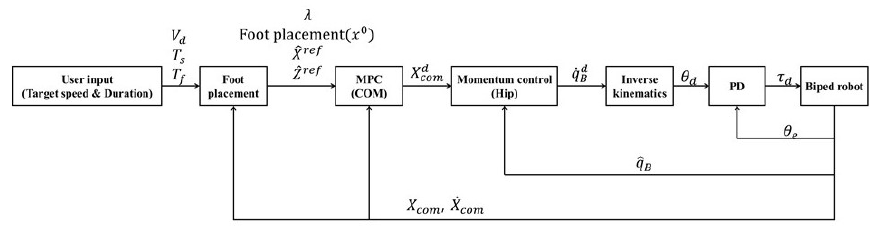
Figure 5. A block diagram for the proposed control loop.